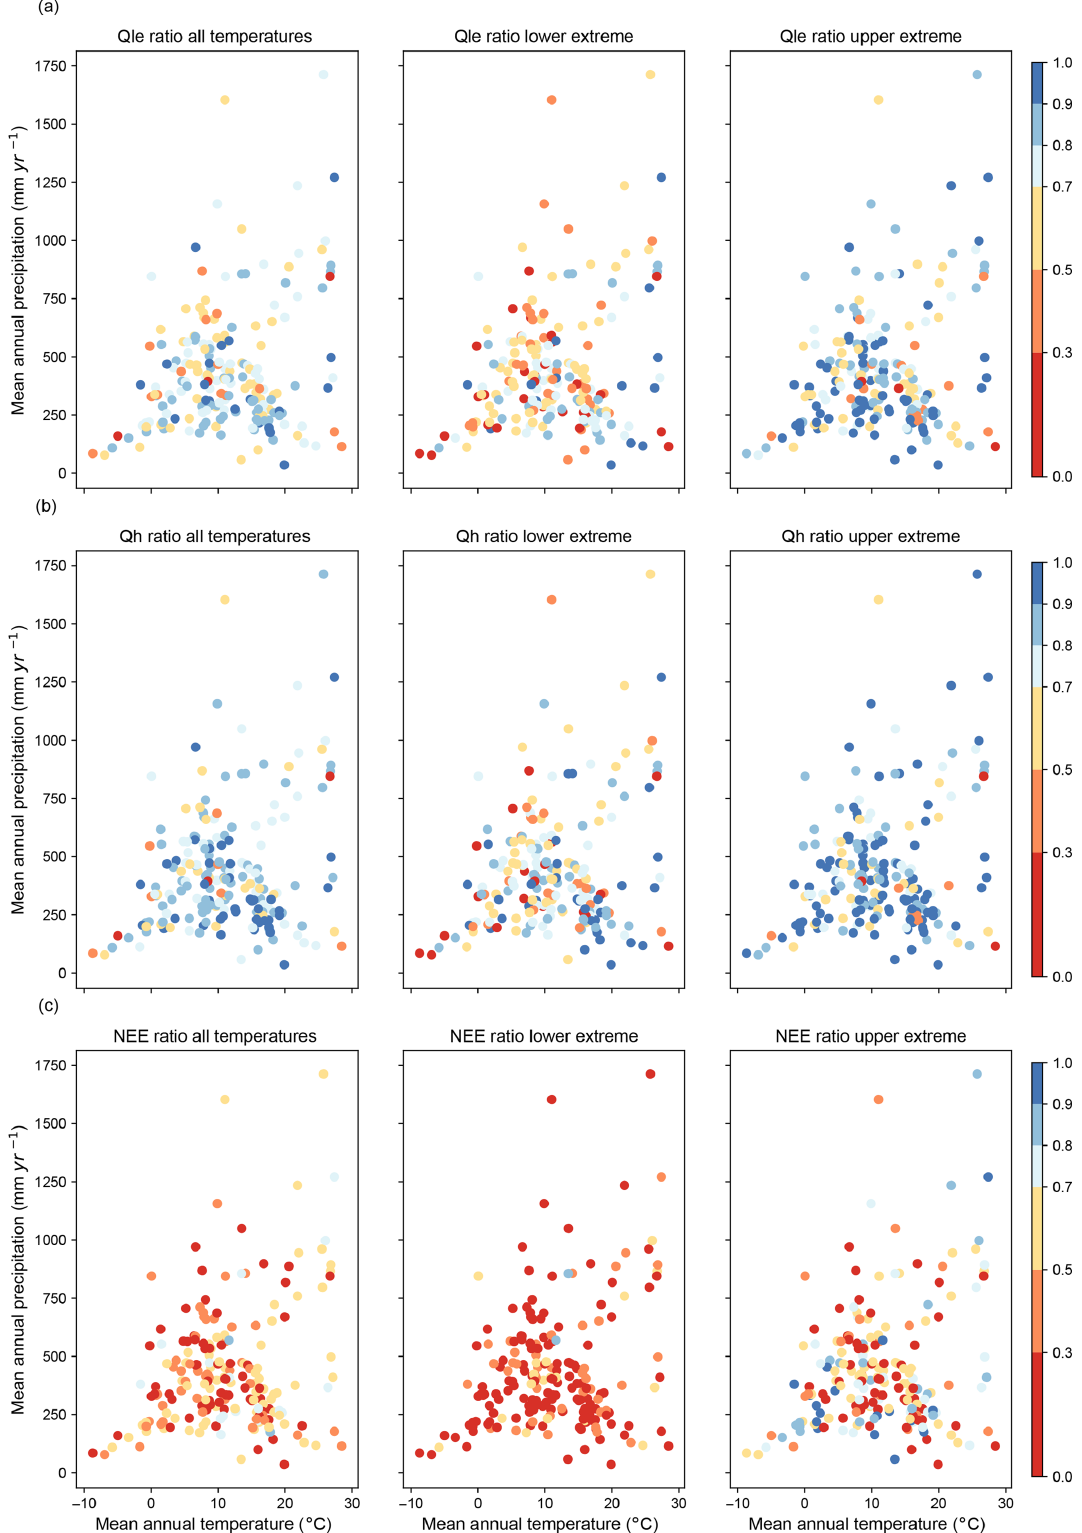
Figure 5. Measurement ratios as a function of mean annual temperature and precipitation. Panel (a) shows the measurement ratios for the overall temperature distribution, the lower extreme and the upper extreme for Q le , (b) for Q h and (c) for NEE,